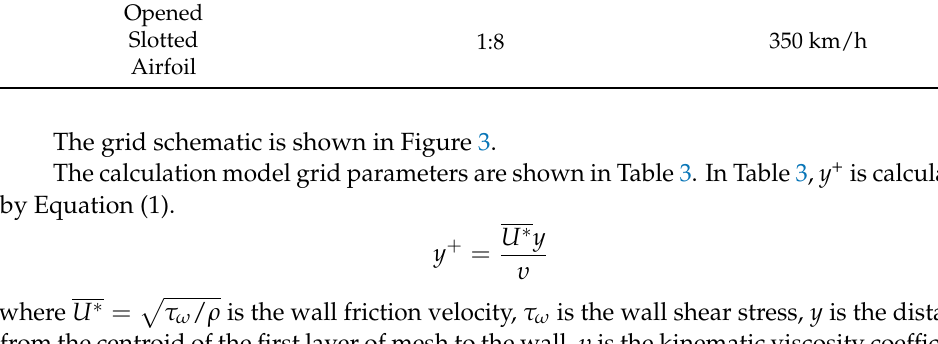
Table 2. Calculated working conditions.